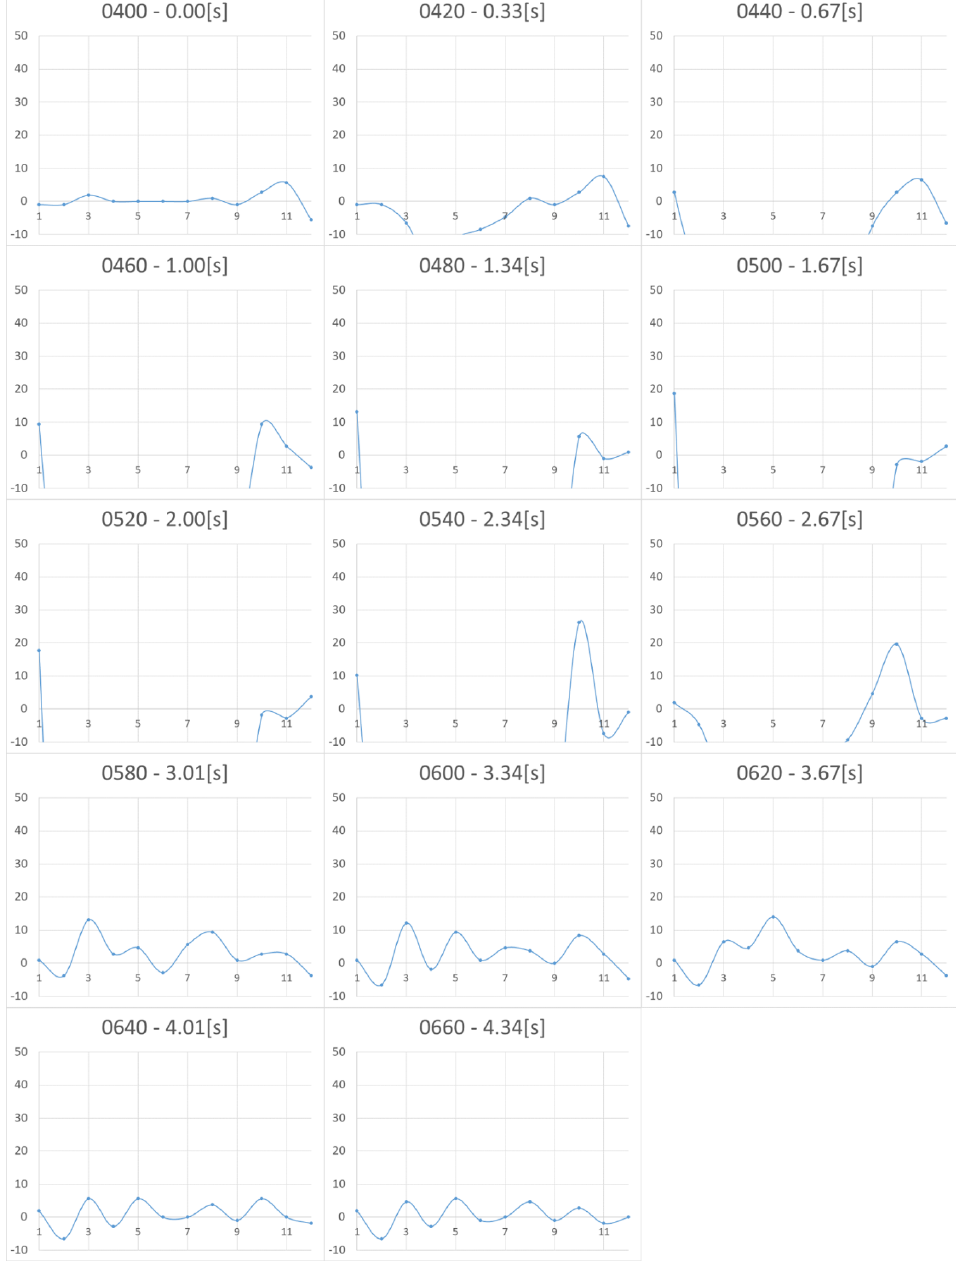
Figure 5. Change in pressure distribution for Natt¯o (2D view, longitudinal section of the center). The vertical axis represents the force (in milli Newton). The horizontal axis represents the location of the sensing point. The four-digit numbers in each graph show the frame numbers at the time of measurement. Measurements were taken in 0.0165 s / frame (60